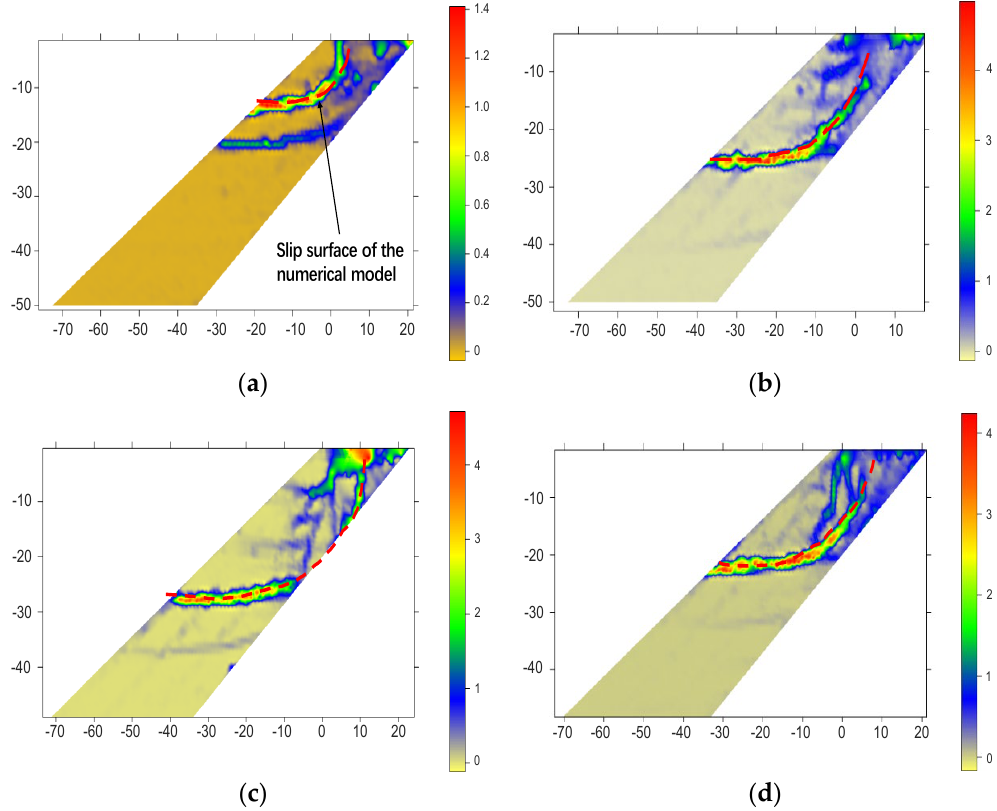
Figure 8. Contour of shear strain in the backfill slope: ( a ) T-1; ( b ) T-2; ( c ) T-3; and ( d ) T-4 (unit: